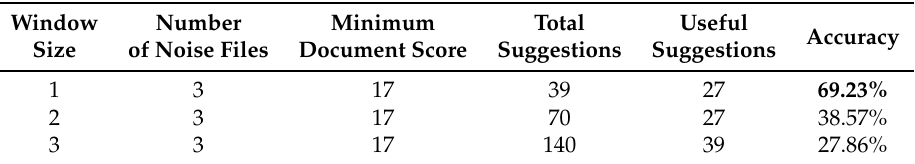
Table 4. Neighbourhood approach – window impact.